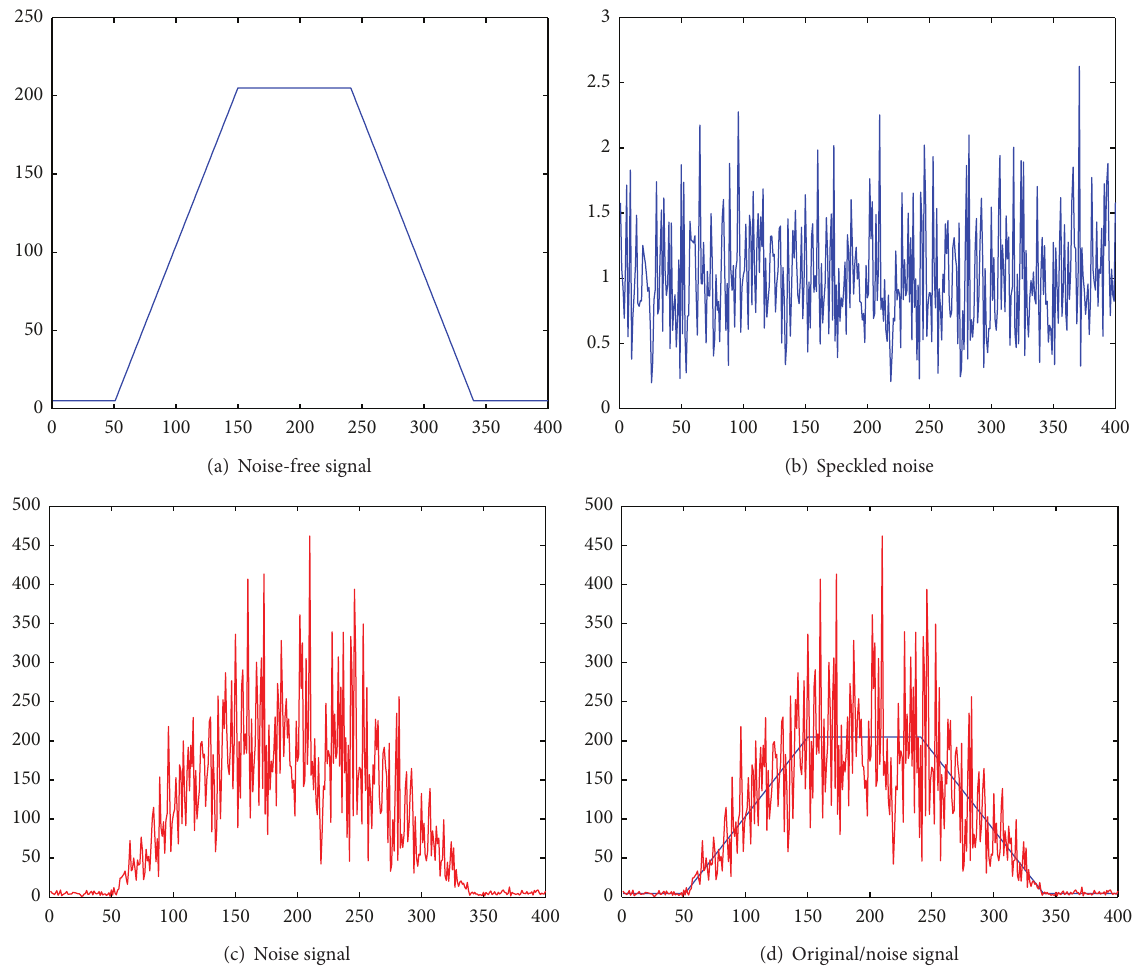
Figure 1: The relation between the influence of the noise and the gray levels. (a) 1D signal 𝑓 ; (b) 1D speckled noise with mean equal to 1 and 𝐿 = 5 ; (c) 𝑓 degraded by the speckled noise; (d) the compare between 𝑓 and the noise signal 𝑓 .